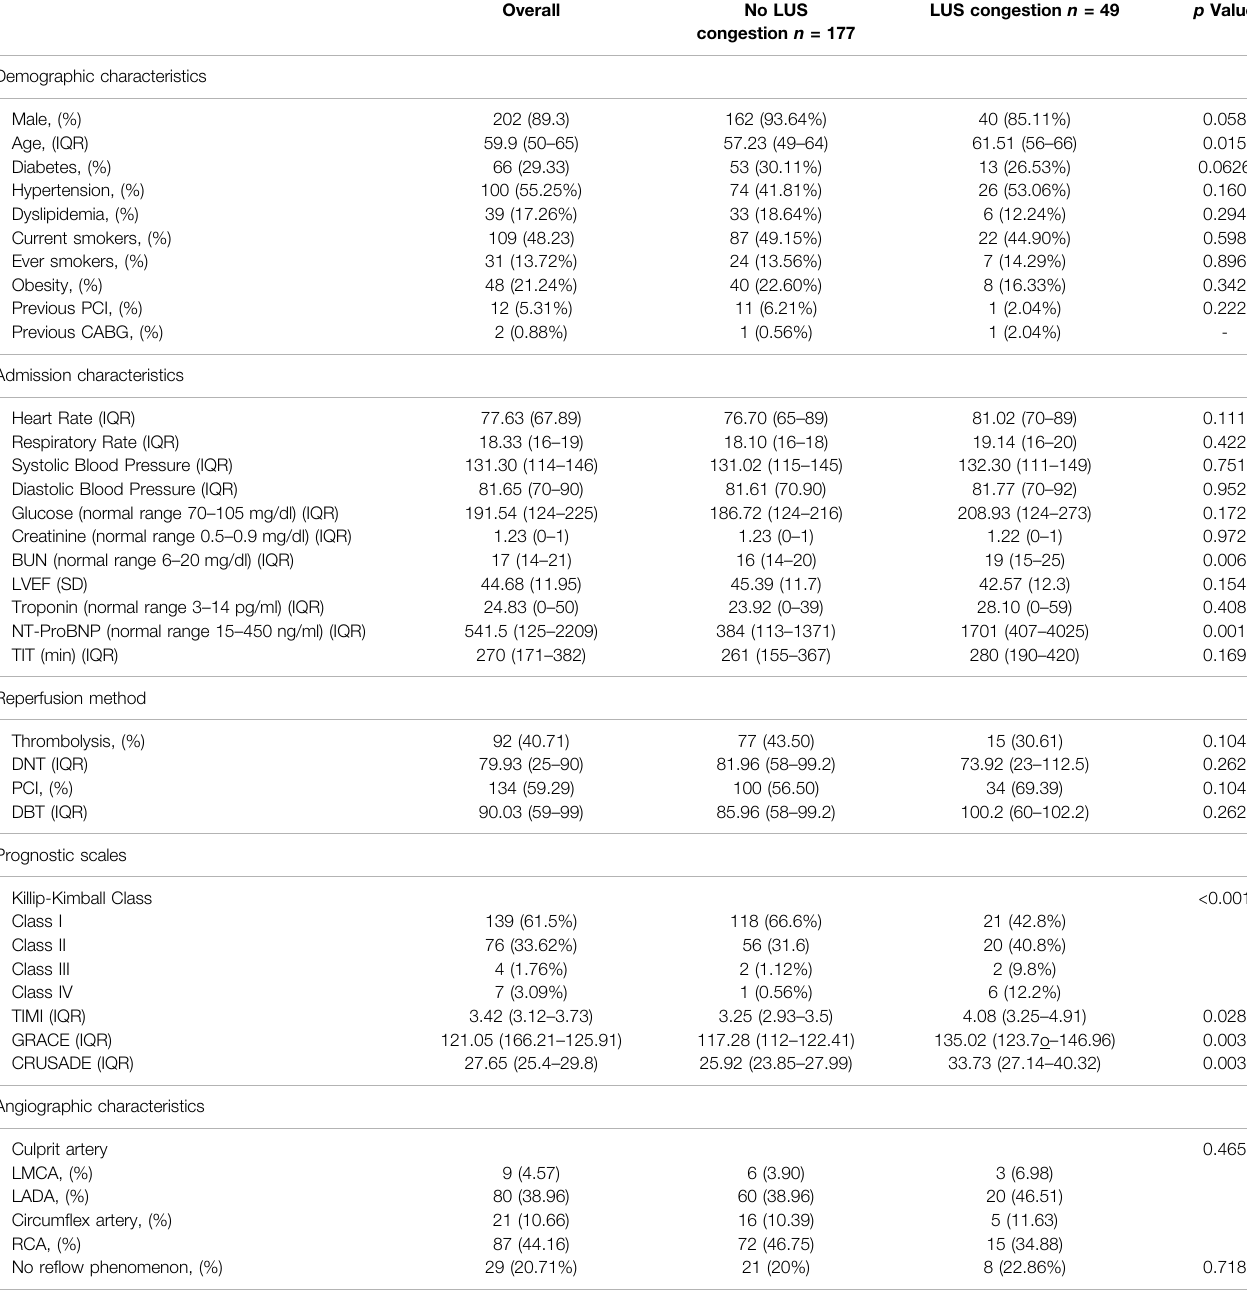
TABLE 1 | General characteristics of the population according to pulmonary congestion evaluated by LUS.